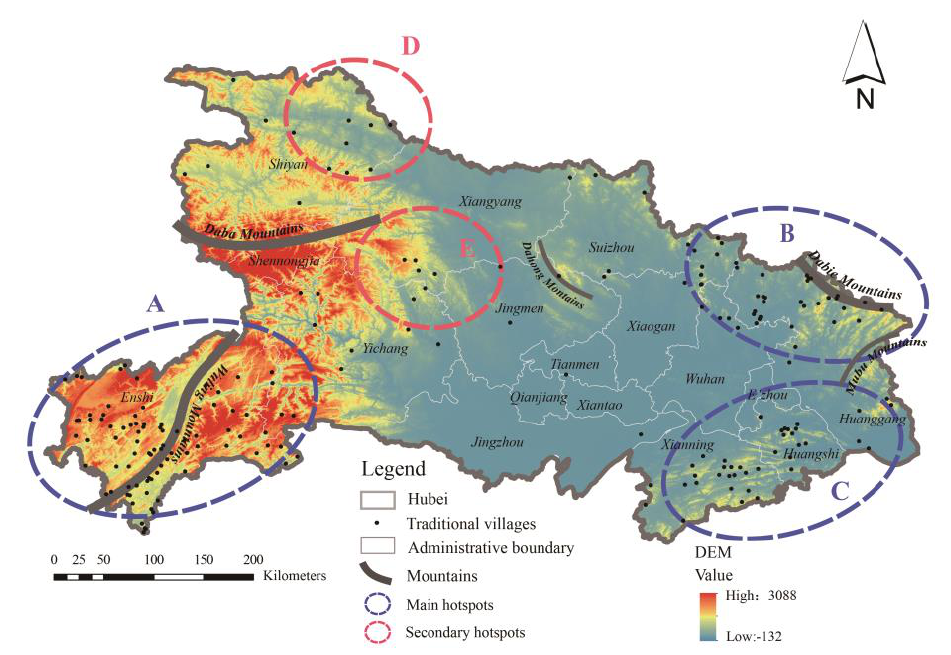
Figure 4. The DEM map and major mountains of Hubei